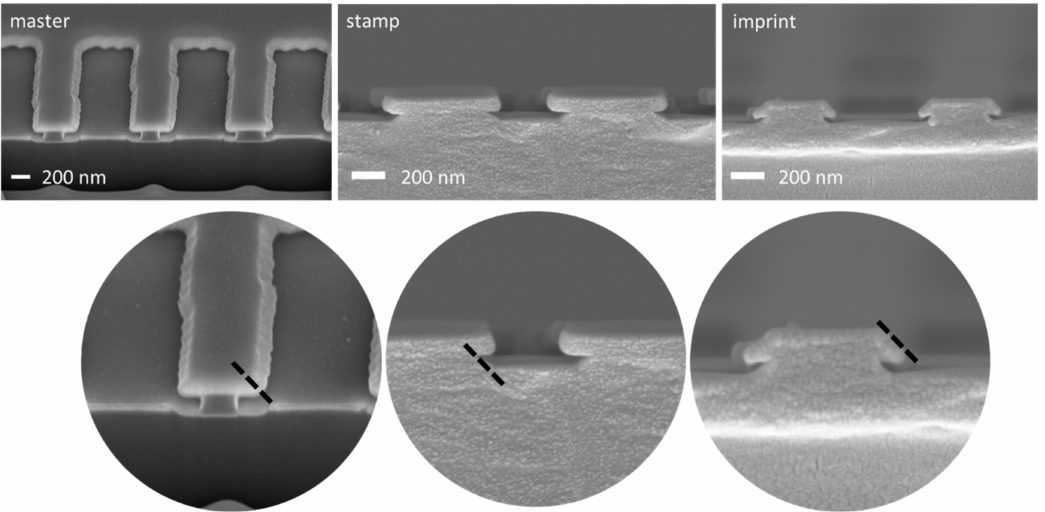
Figure 6. SEM cross-sectional images of the sample sequence from the master structure [35] (left) over the stamp in NILCure ® JR5 (center) and the imprinted structures in NILcure ® JR5 (right). The second row shows close-ups from the images in the upper row.